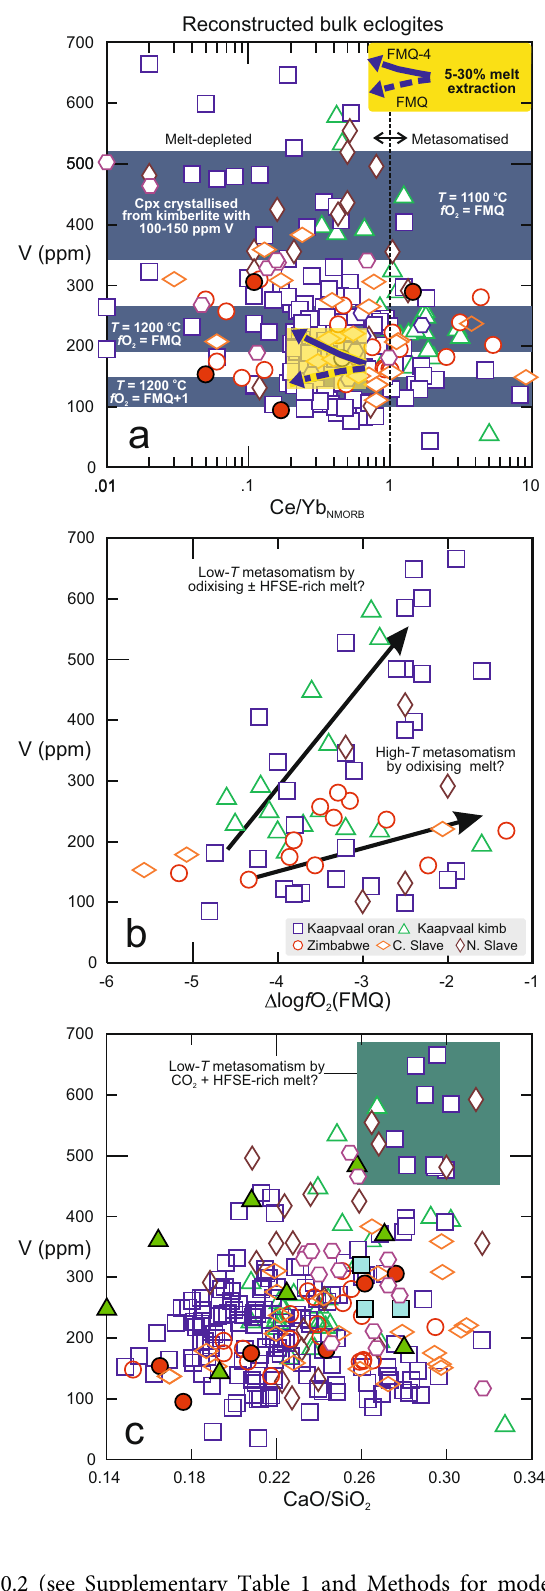
Fig. 4 Effects of partial melt extraction and metasomatism on V abundances in eclogites. a Vanadium abundances (ppm) in reconstructed bulk eclogite xenoliths and DI as a function of normal mid-ocean ridge basalt (NMORB)-normalised Ce/Yb, a proxy for melt depletion and enrichment. Shown for comparison is the modelled trend (yellow box) for partial melt extraction from rutile-eclogite, with a moderate decrease of V abundances at relatively oxidising conditions of Δ log ƒ O 2 (FMQ) = 0, similar to the modern ambient mantle 72 . For Δ log ƒ O 2 (FMQ) = − 4, at the low end causes an increase in V abundances (modelling parameters and rationale in Methods; Supplementary Table 4). Also shown is the effect